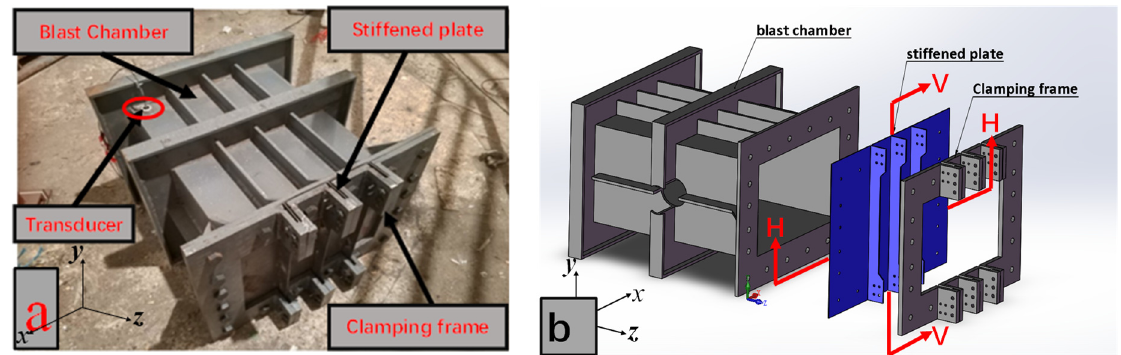
Figure 1. Experimental set up for confined explosion: ( a ) experimental arrangement, ( b ) schematic of experimental arrangement.